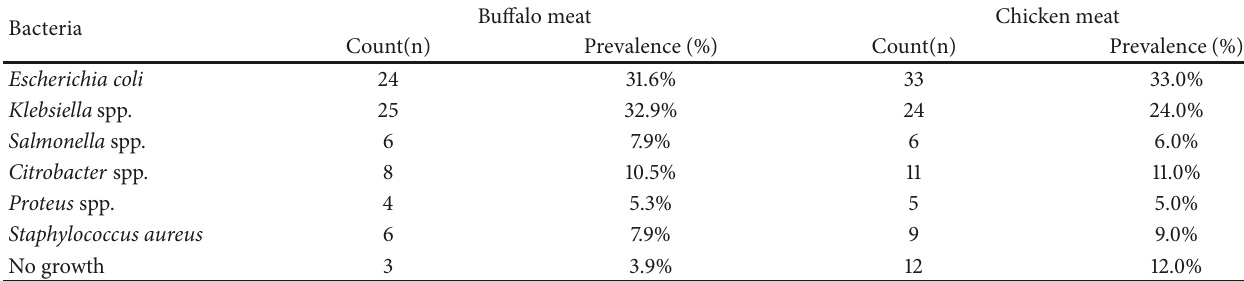
Table 1: Bacterial prevalence from raw meat of buffalo and